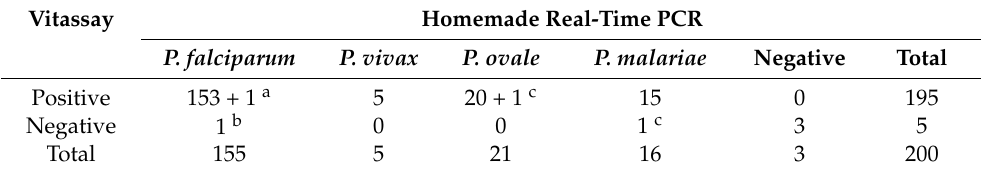
Table 3. Comparison of the Vitassay qPCR Malaria 5 and the homemade real-time PCR results.